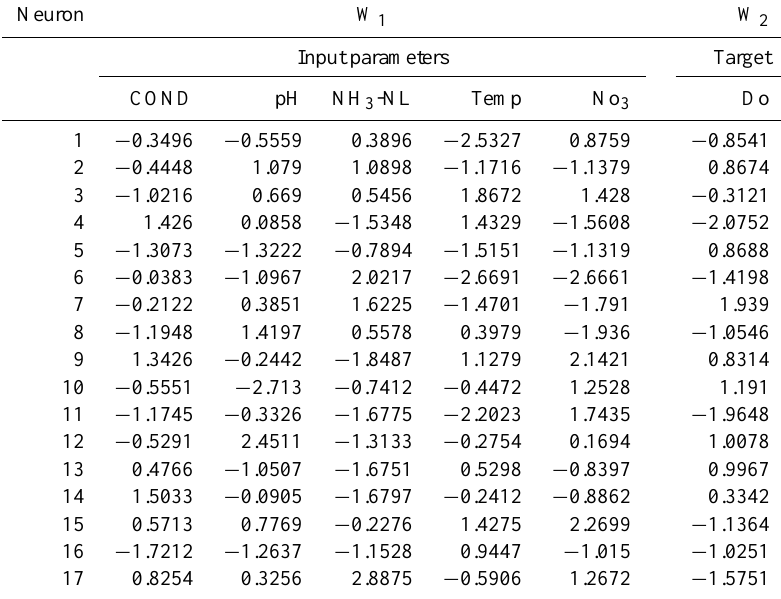
Table 5. Connection weights between the input and hidden layers (W 1 ) and weights between hidden and output layers (W 2 ) .